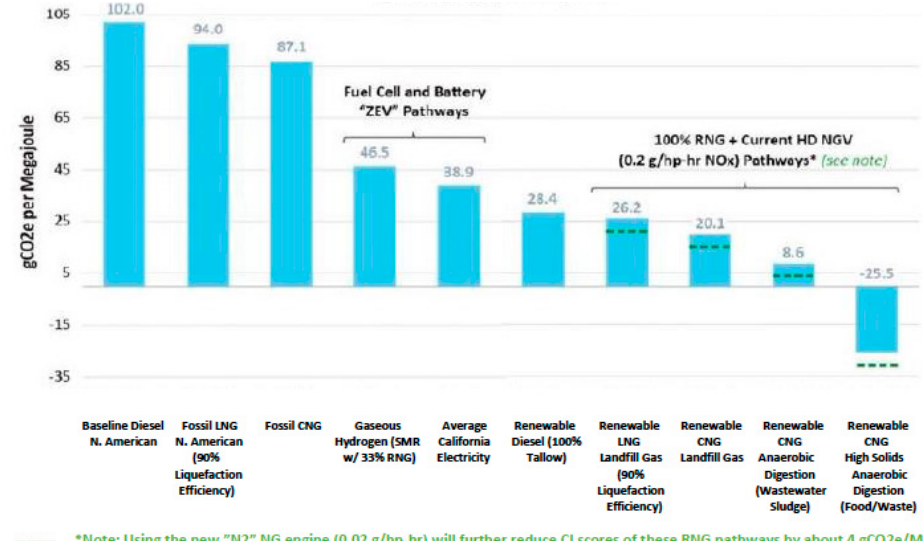
Figure 4. Carbon intensity scores of alternative fuel pathways for heavy-duty vehicles (source: California Air Resources Board 2015, low carbon fuel standard final [69]).